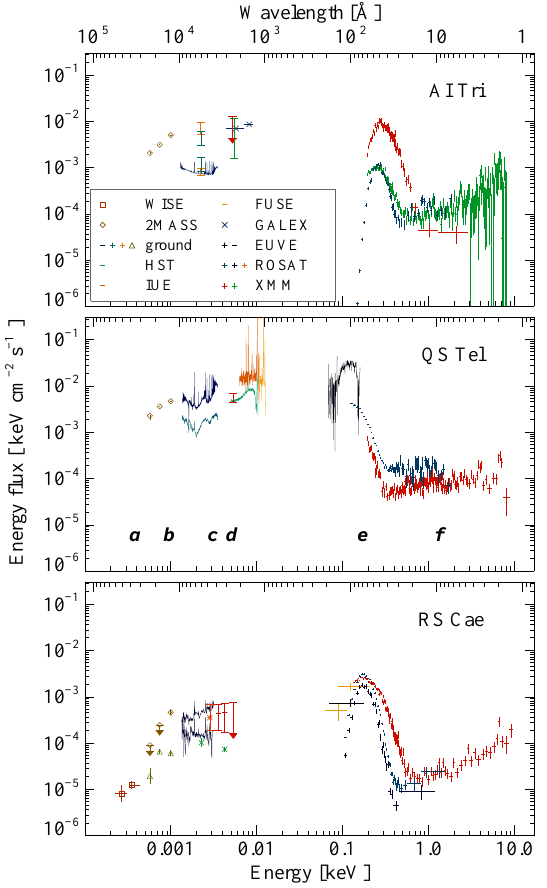
Figure 1: Observed SEDs of three X-ray soft polars from IR to X-rays: our XMM-Newton and optical plus archival data at different epochs and accretion states (cf. Traulsen et al. 2010, 2011, 2014). The X-ray spec- tra are unfolded using the best-fit models.